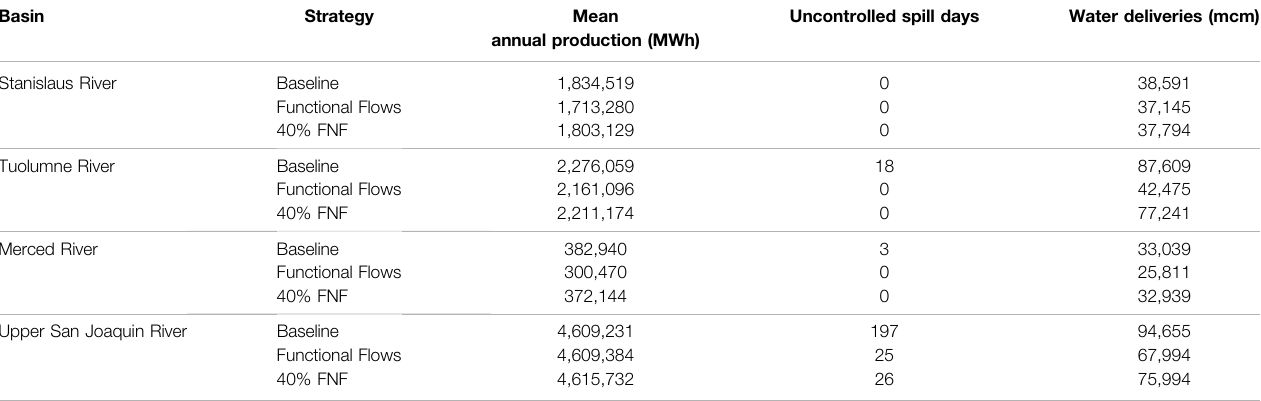
TABLE 4 | Mean annual hydropower production, number of uncontrolled spill days, and total water deliveries for each basin given alternative environmental fl ow requirements.